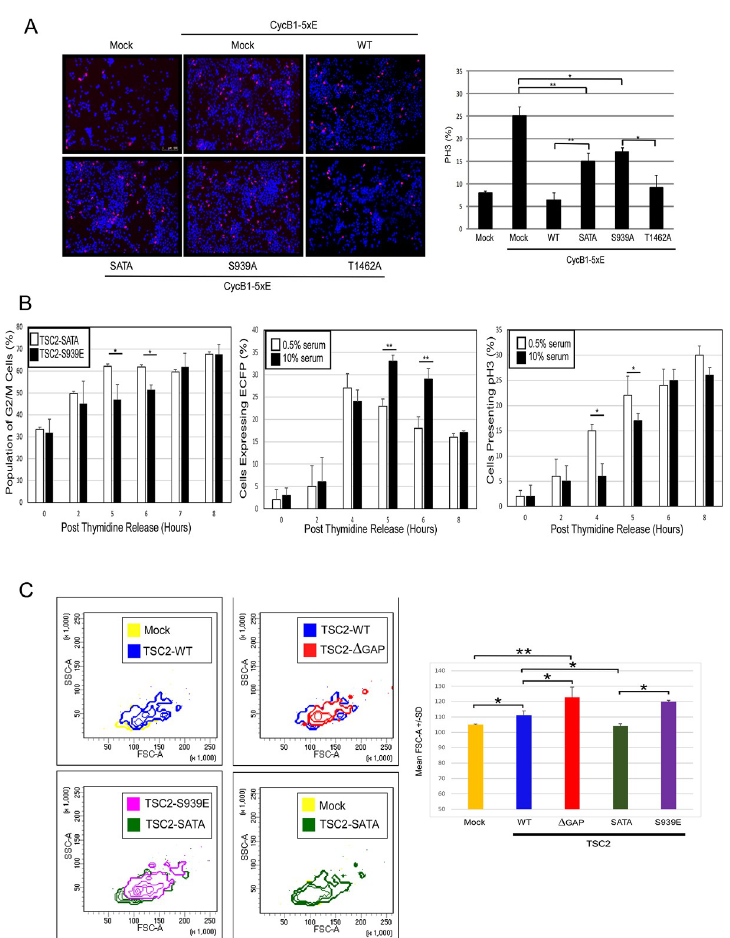
Fig 3. CycB1 localization and cell growth are regulated by TSC2 in mTORC1-independent fashion. (A: left panel) Representative images depicting Hoechst stain (Blue) and phospho-histone H3-Alexa 568 (Red) indicated as a merge. The panels are presented at 10x magnification. (A: right panel) Quantification of the percent of cells staining positive for phospho-H3 scored for each sample (Y-axis). Scored over 1000 cells/transfection over 3 separate transfections. Error bars represent SD. Unpaired t-test, � p < 0.05 and �� p < 0.01. (B: left panel) HEK293 cells were transfected with either SATA or S939E, 18 hrs after transfection the cells were arrested in S phase with double thymidine block. Cells were released from the block and collected at indicated time points for PI staining and flow cytometry analysis. ( B: middle and right panels ) 293 cells were transfected with the pCCNB1-ECFP vector, 18 hrs after transfection the cells were arrested in S phase with double thymidine block. Cells were released from the block in 10% serum and cultured in 0.5% or 10% serum and collected at the indicated time points. (B: middle panel) The percent of cells expressing ECFP were divided for the total number of cells staining positive for TOPRO-3 (Y-axis). Cells cultured at 10% serum (solid bars) and 0.5% serum (hollow bars) were scored over 1,000 cells/transfection. (B: right panel) The cells were immunoblotted with a nuclear stain (TOPRO-3), pH3 antibody. The percent of cells staining positive for pH3 are divided by total cell number staining positive for TOPRO-3 (Y-axis). Error bars represent SD over 3 separate transfections. Unpaired t-test, � p < 0.05 and �� p < 0.01. (C) HEK293 cells were transfected with Mock control, TSC2-WT, TSC2- Δ GAP, TSC2-SATA and TSC2-S939E. 18 hrs after transfection the cells were arrested in S phase with double thymidine block. Cells were released from the block in 10% serum and 5 hrs after the cells were harvested and fixed in 70% cold ethanol. Transfected cells were gated using a flag immune stain and G2/M population was gated using propidium iodite DNA stain. Left panel shows Contour plots of one representative SSC-A x FSC-A spectra, forward side scatter (X-axis) used as a measure of cell size. Right panel graphic shows the mean FSC-A values obtained from 3 different transfections. Error bars represent SE over 3 separate transfections. Unpaired t-test, � p < 0.05 and �� p < 0.01.